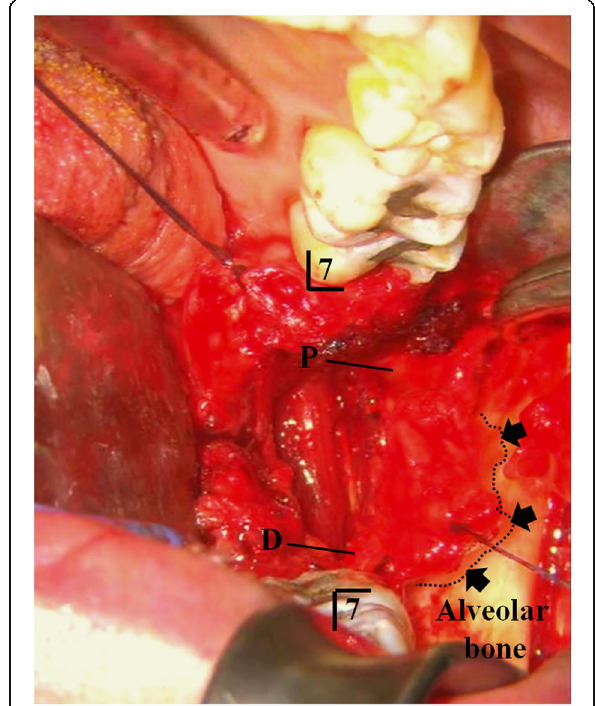
Fig. 2 LN injury site and a large granuloma of LN. Operative findings; the torn LN and scar tissue are identified in the socket of wisdom tooth (arrow). P: Proximal end LN, D: Distal end